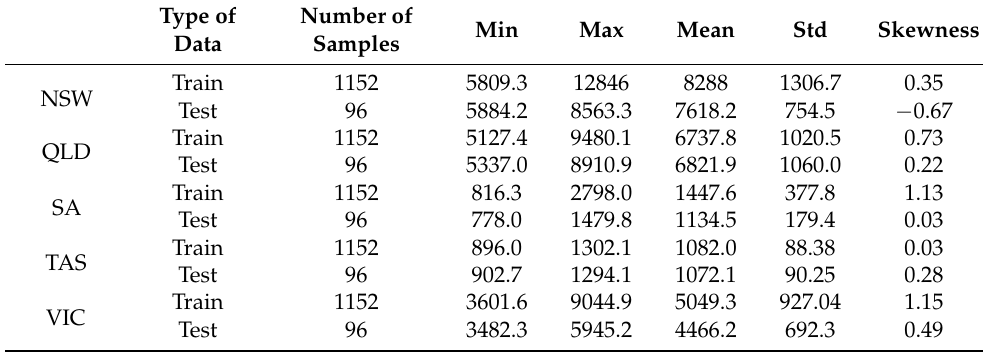
Table 4. Statistical parameters of the electrical load data in five regions of Australia.